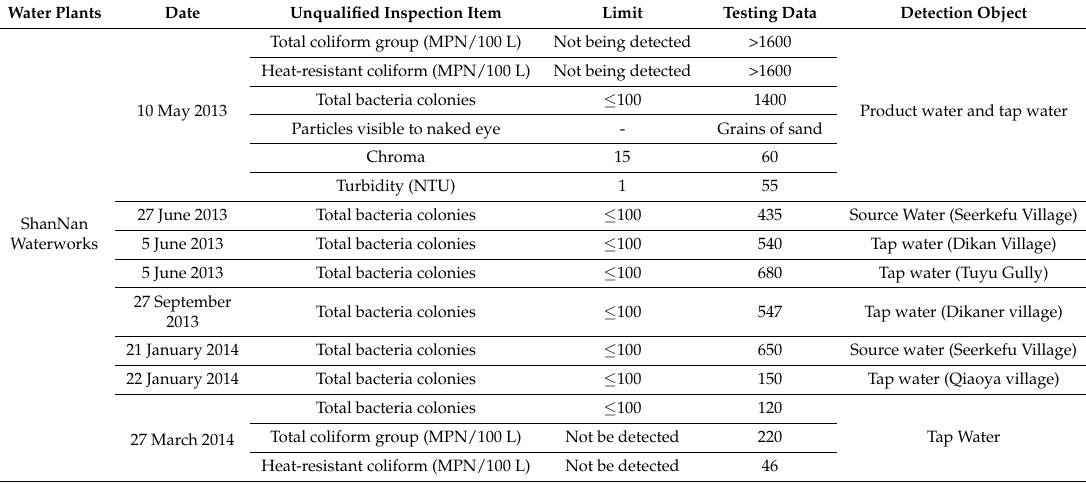
Table 2. Water quality testing data from water plants during